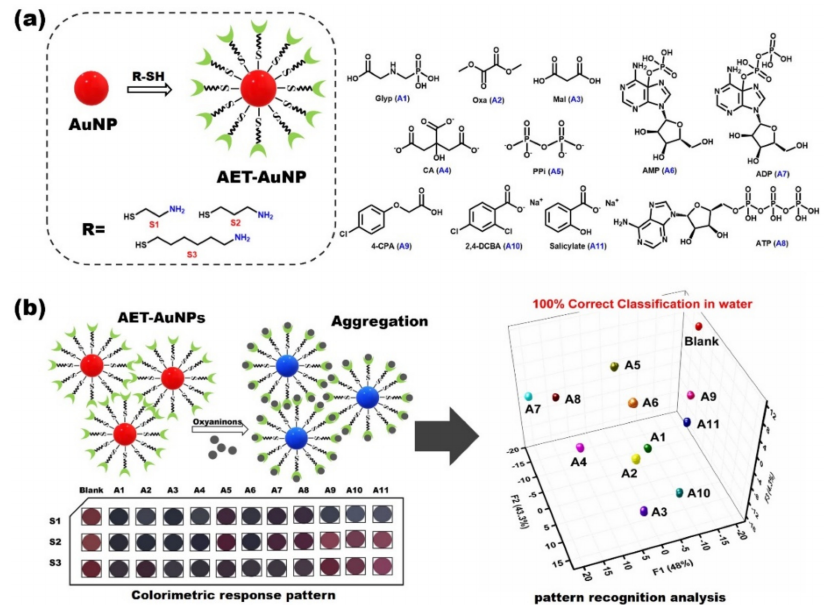
Figure 1. Molecular structures of oxyanion analytes (A1–A11) and AET–AuNP sensors ( a ); diagram of colorimetric sensor array and oxyanion detection principles ( b ).